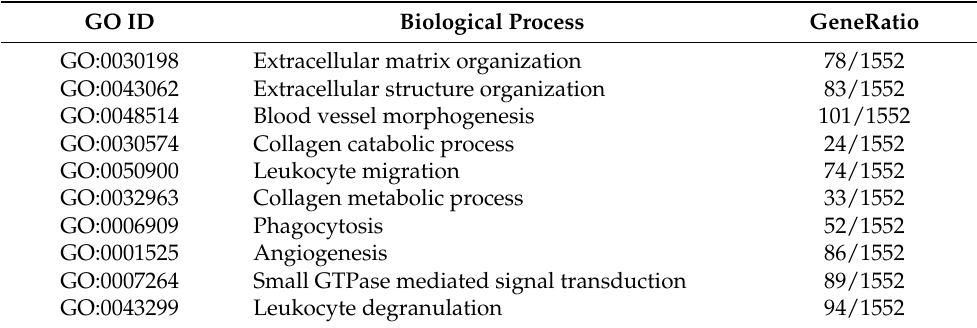
Table 7. Top 10 biological processes significantly (padj ≤ 0.01) enriched in genes differentially expressed in M2_B versus M0_B